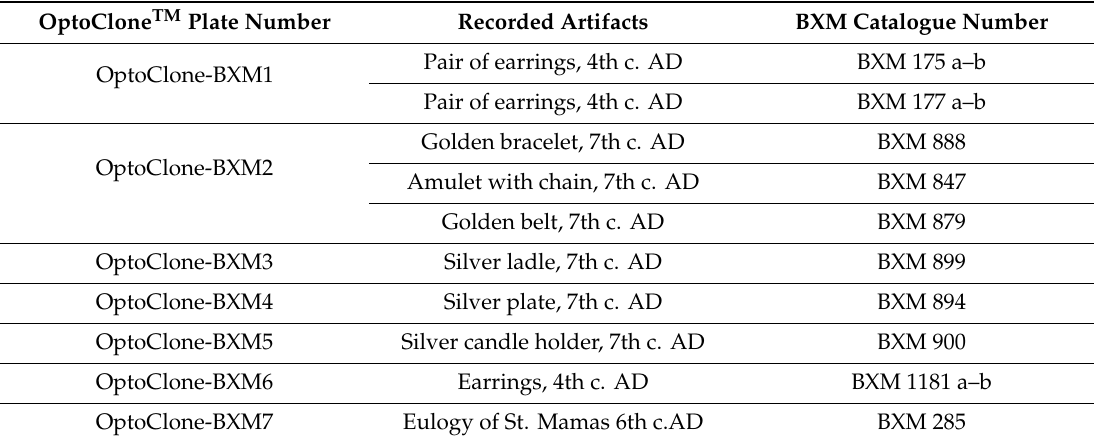
Table 2. Byzantine & Christian Museum of Athens artifacts recorded as OptoClones TM .